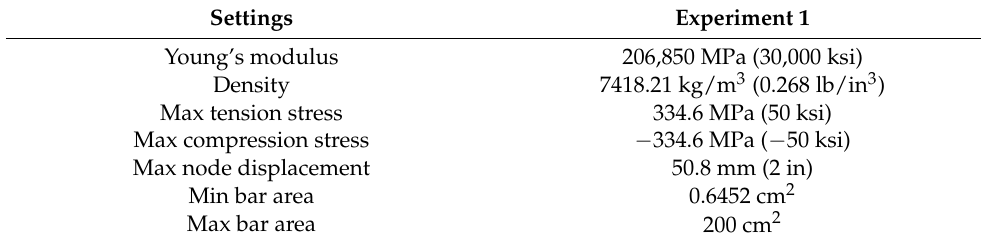
Table 2. Material properties and constraint parameter settings in experiment 1.